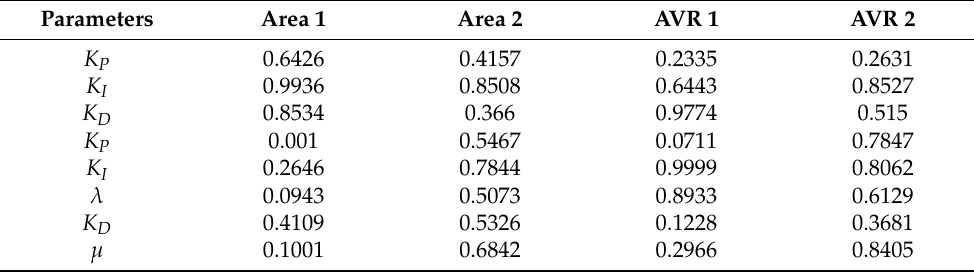
Table 11. Cascaded PID-FOPID controllers’ gain for GCSC coordination.